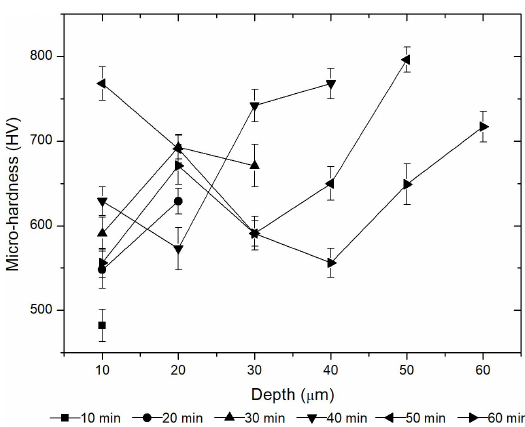
Figure 7. Micro-hardness profile in the cross-section of Ni-Co/SiC nanocomposite coatings as a function of galvanostatic deposition